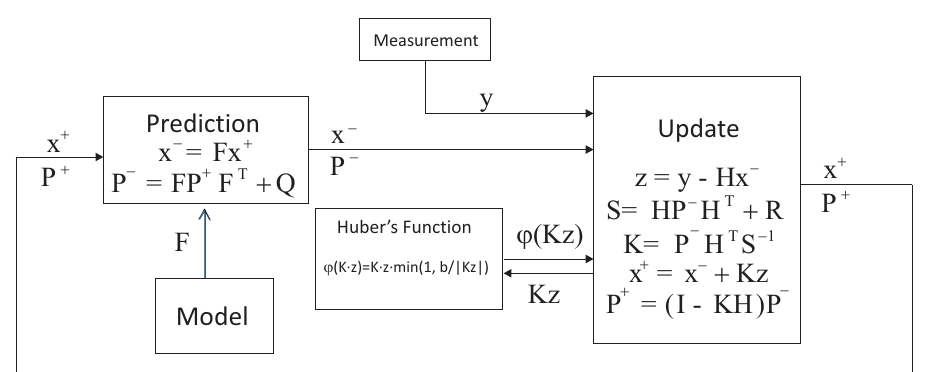
Figure 5. Block diagram of the robust Kalman